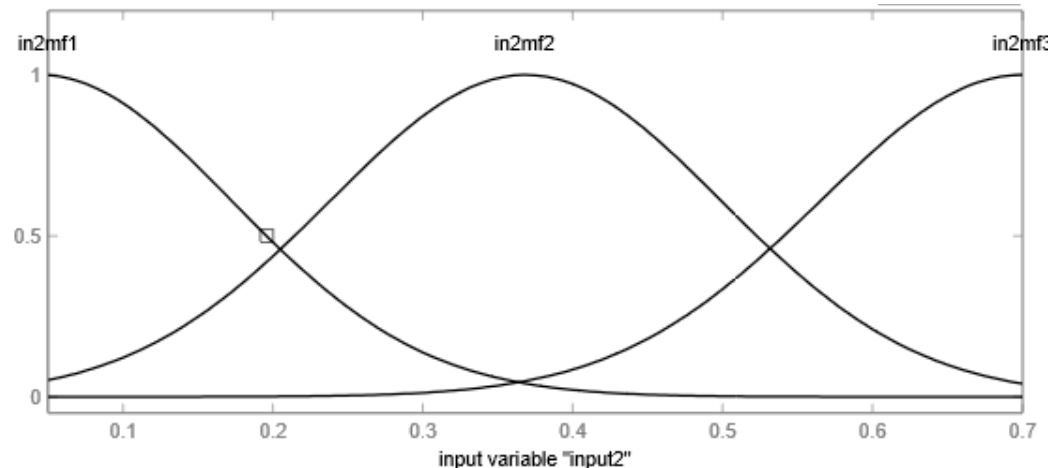
Figure 11. Membership function for input variable 2 i.e., RBCC.